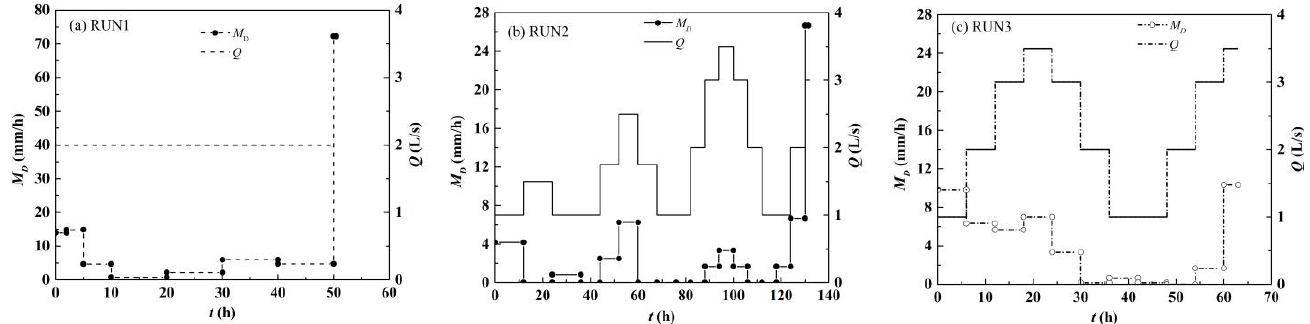
Figure 5. Reduction rates for the neck width M D during different periods with ( a ) RUN1, ( b ) RUN2, and ( c ) RUN3; the variation in M D was closely related to the discharge and increased to different degrees when approaching cutoff in all three runs.